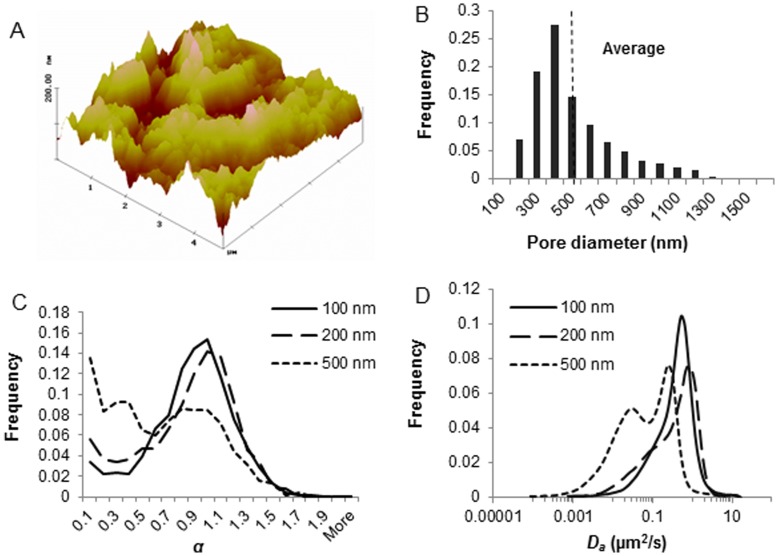
Evaluation of the microstructure of porcine tracheal respiratory mucus.(A) AFM visualization (5 µm×5 µm) of porcine tracheal respiratory mucus. (B) Pore size distribution of the porcine tracheal respiratory mucus as measured by AFM. Pore diameters were analyzed by the line profiling of the 3-D images. Three scans were performed for each sample, and three independent samples were measured. The dashed line indicates the average of pore diameters (n = 500). (C) Transport modes of 100, 200 and 500 nm PEGylated nanoparticles indicated by α value. More than 2000 trajectories from 3 independent experiments were tested to obtain α. (D) Distributions of the apparent diffusion coefficient of PEGylated nanoparticles. Trajectories of 10 steps were analyzed for each of the 2000 diffusion coefficients. Distributions were refined with MEM.